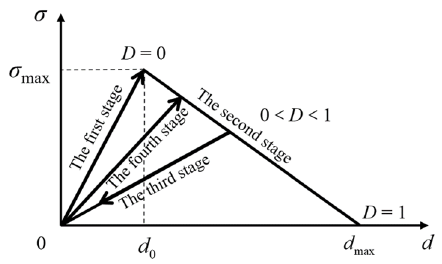
Figure 2. Sketch of the bilinear constitutive law.